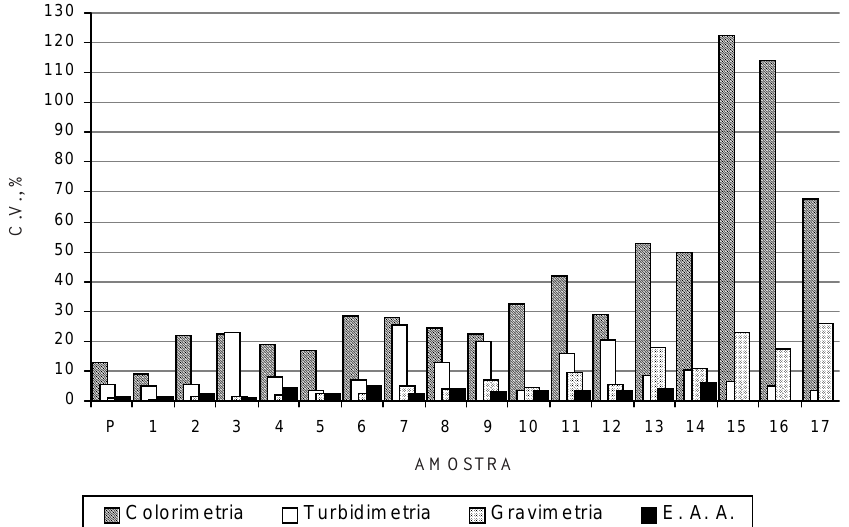
Figura 1. Coeficientes de variação, entre cinco repetições, das técnicas de determinação de S, aplicadas ao extrato de água